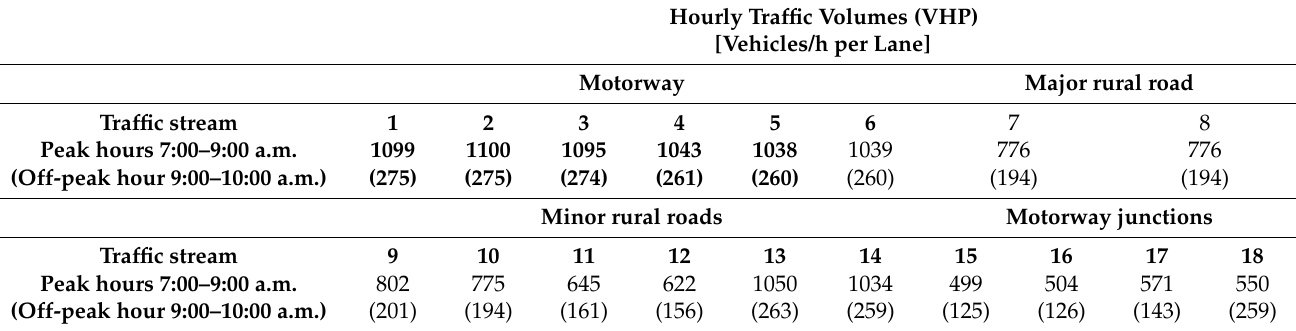
Table 2. Hourly traffic volumes in the two peak hours (7:00–9:00 a.m.) and one off-peak